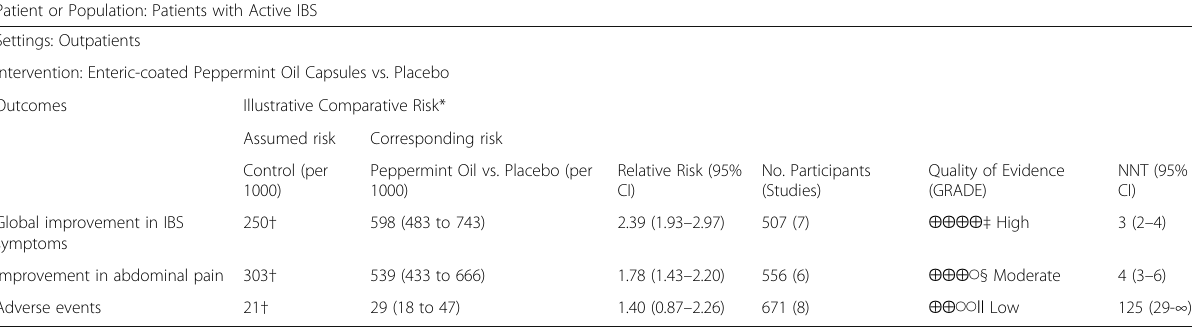
Table 3 Summary of Findings. Peppermint Oil vs. Placebo for the Treatment of IBS Patient or Population: Patients with Active IBS Settings: